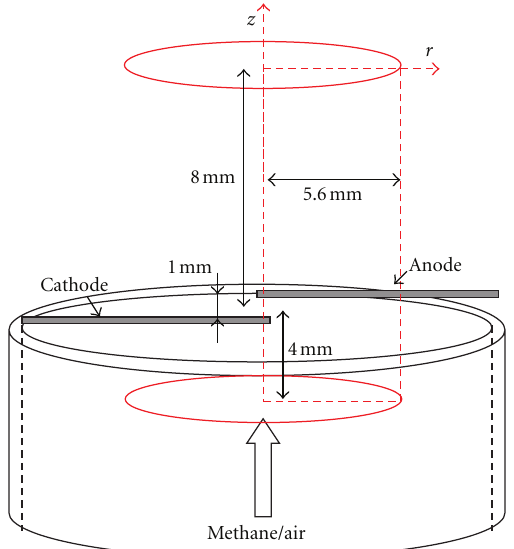
Figure 1: 2-D kinetic simulation